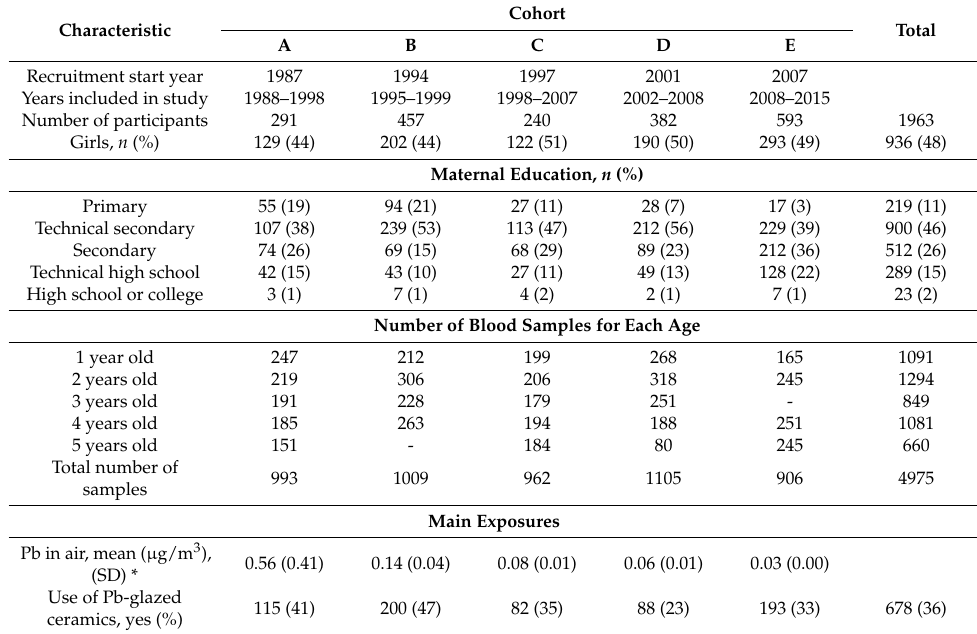
Table 1. Characteristics of study participants.